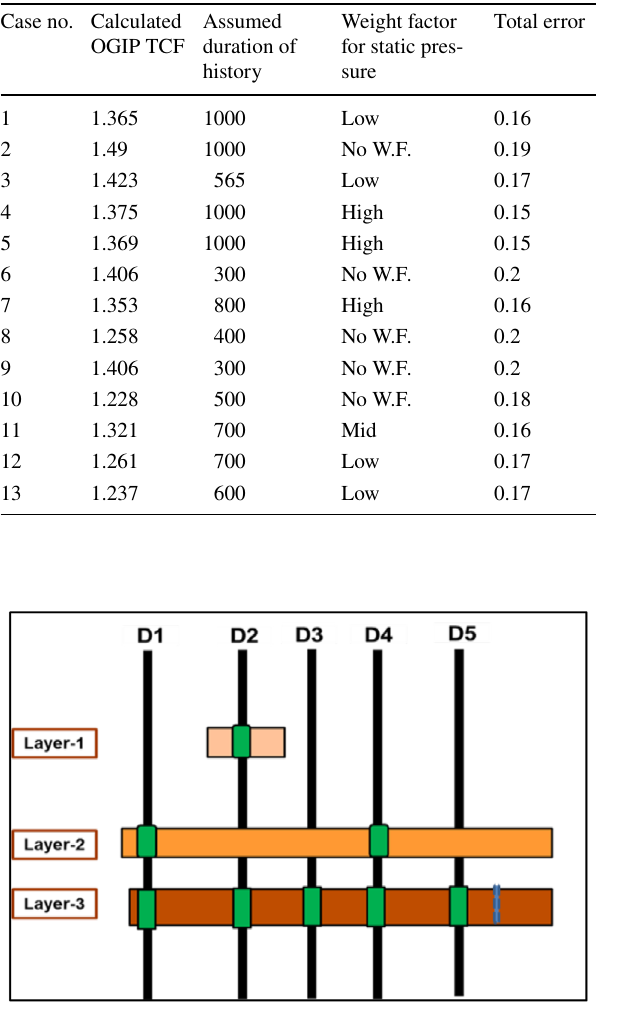
Table 5 Sensitivity analysis for field case 1